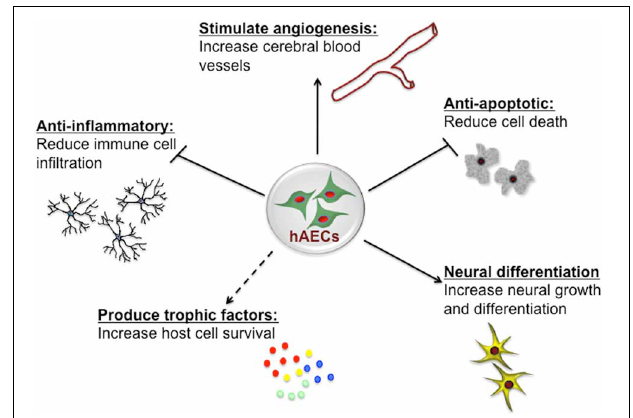
FIGURE 1 | Potential neuroprotective and neurorestorative mechanisms of human amnion epithelial cells (hAECs). hAECs have immunomodulatory properties which lead to a reduction of immune cell infiltration into the brain, thus reducing inflammation. They secrete various trophic and angiogenic factors which stimulate angiogenesis, neuronal differentiation and survival, and decrease apoptotic cell death, thus leading to improved functional